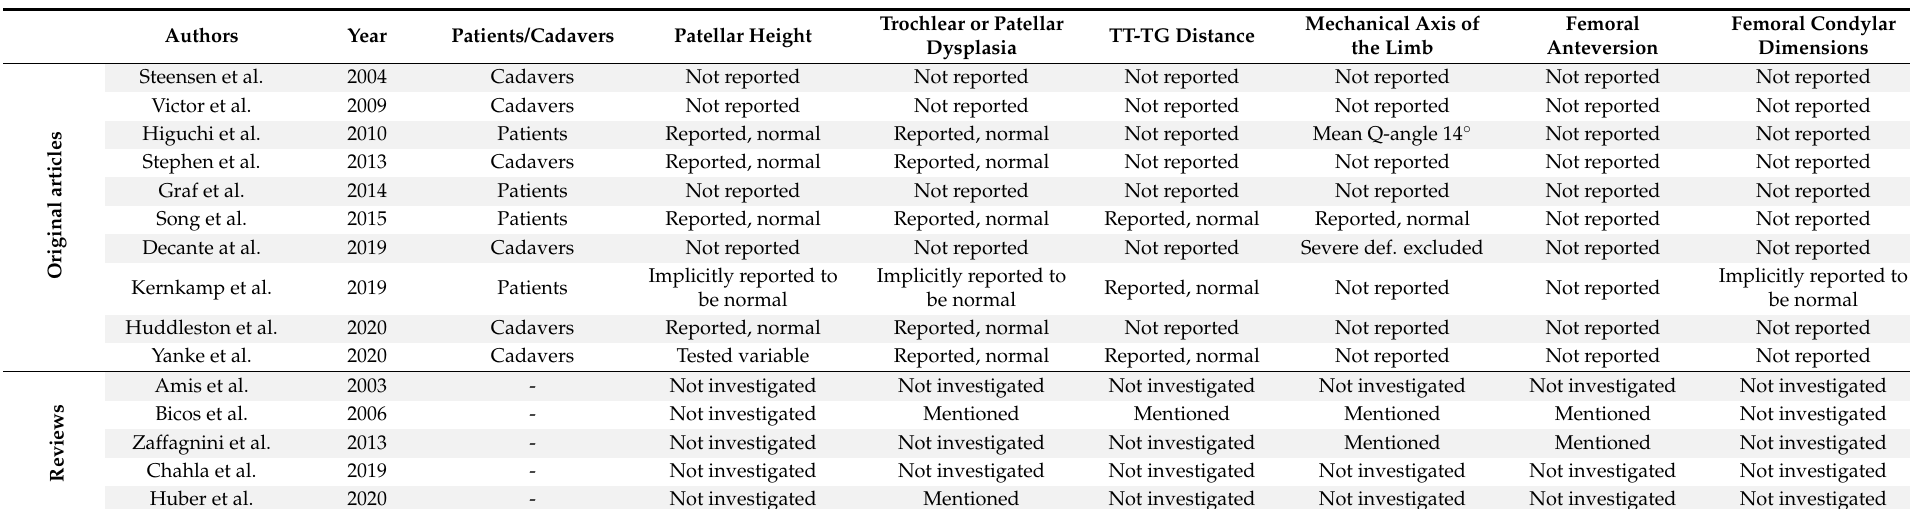
Table 4. Morphology of participants’ patellofemoral joints in included